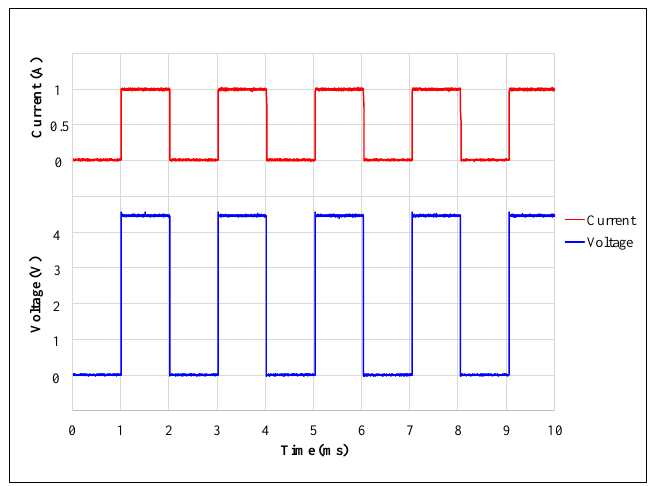
Figure 19. Voltage and current signals of the single-phase switched reluctance motor at a maximum speed of 1500 rpm.